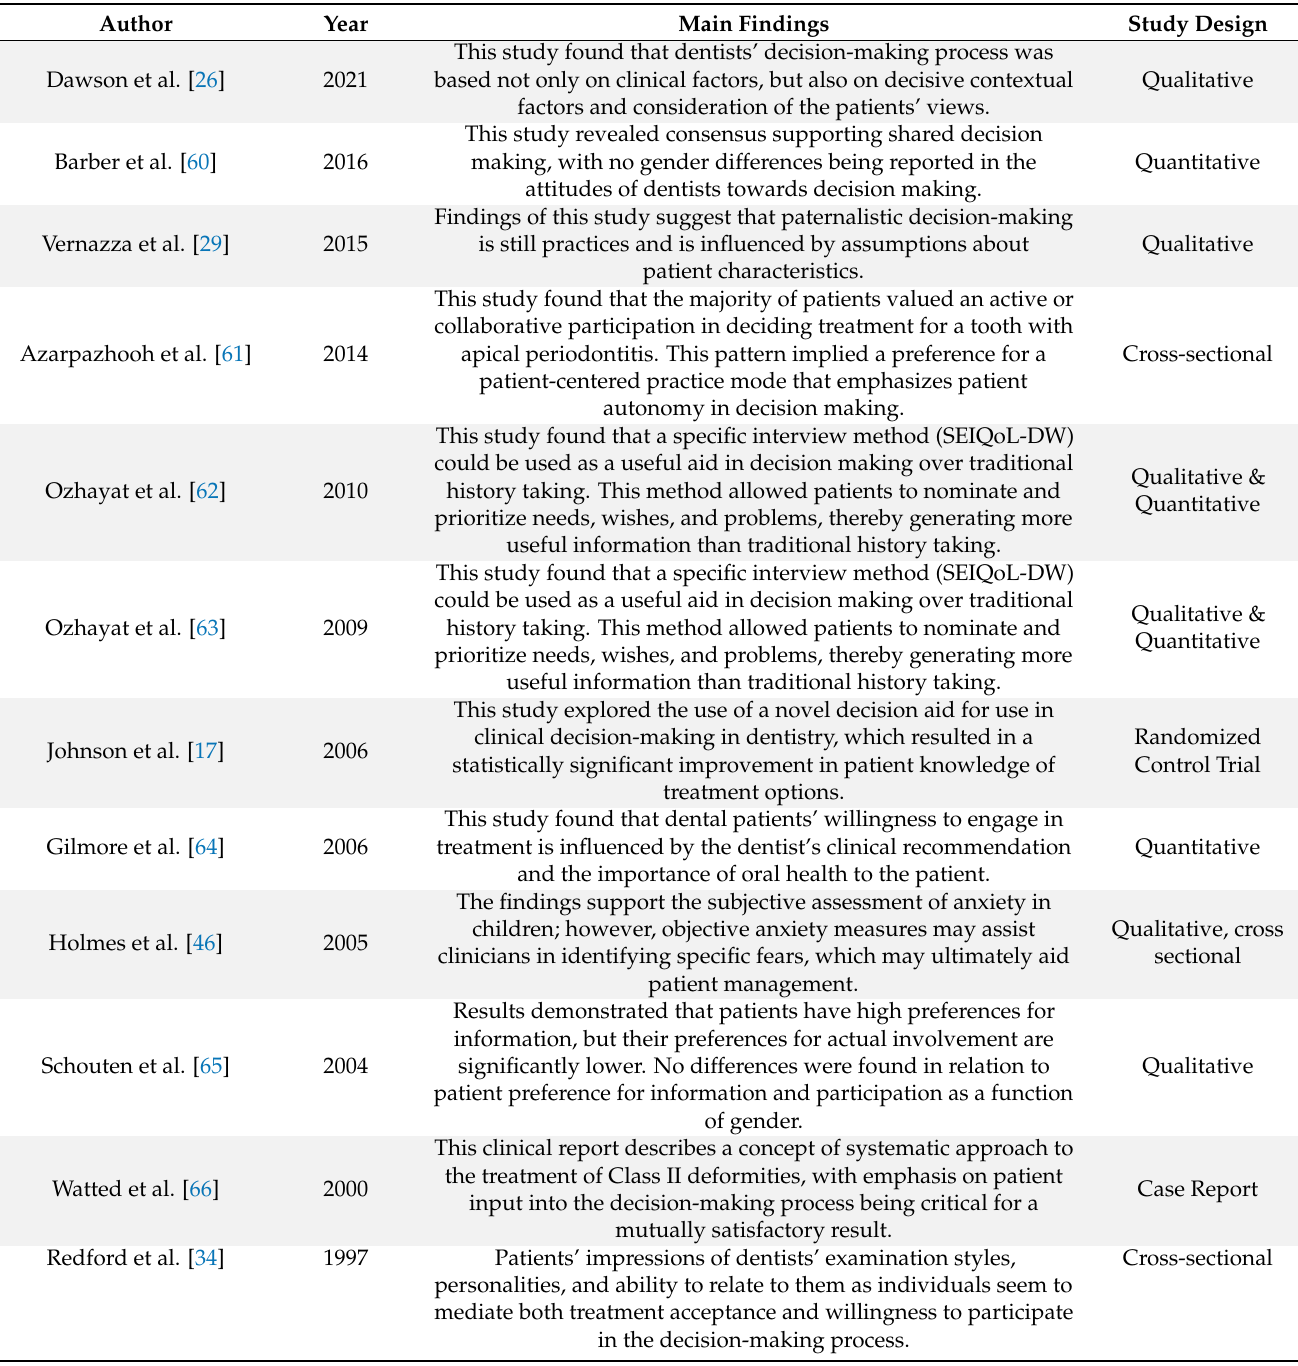
Table 4. Extracted articles that investigated patient preferences and perceptions in clinical decision making under